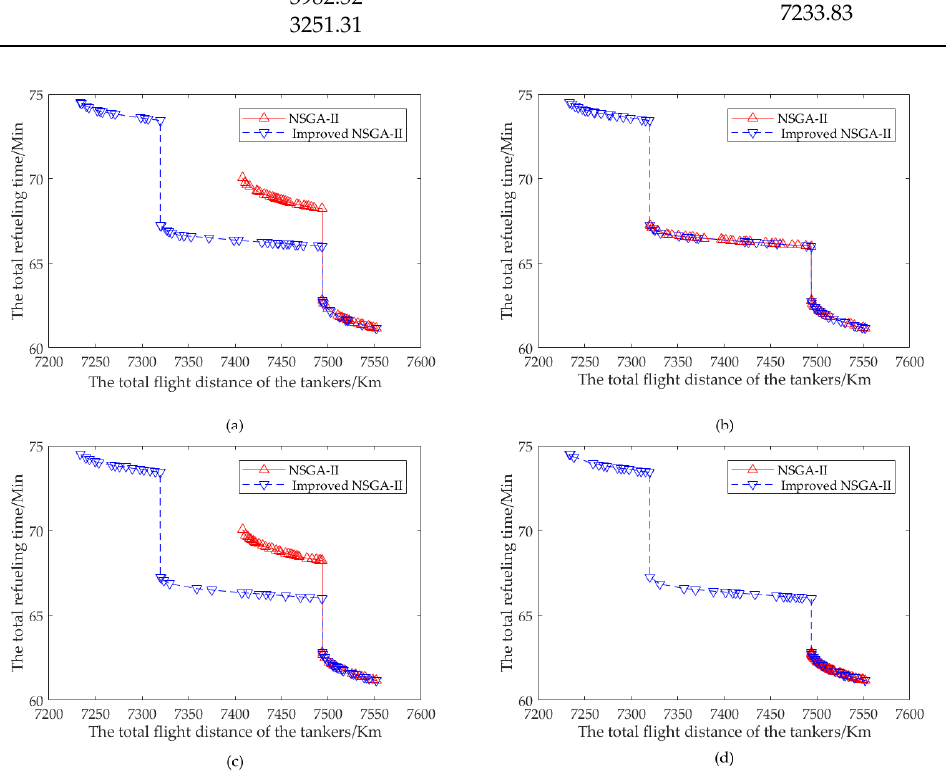
Figure 14. Comparison of objective function values of the Pareto solution sets in two algorithms under different four evolution algebra. ( a ) Result of Pareto solution obtained by two algorithms in 500 generations; ( b ) Result of the Pareto solution obtained by two algorithms in 1000 generations; ( c ) Result of the Pareto solution obtained by two algorithms in 1500 generations; ( d ) Result of the Pareto solution obtained by two algorithms in 2000 generations.